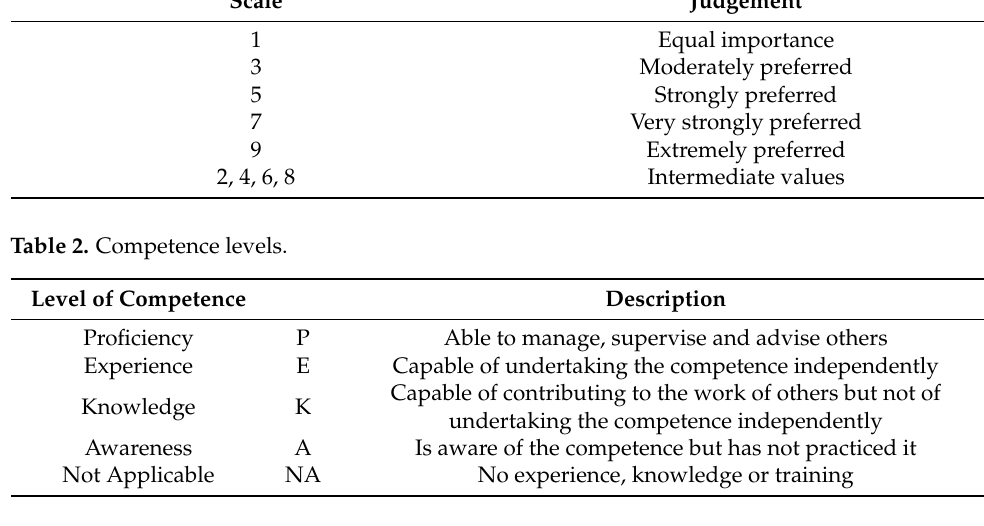
Table 3. Pairwise comparison matrix of the main criteria with respect to the